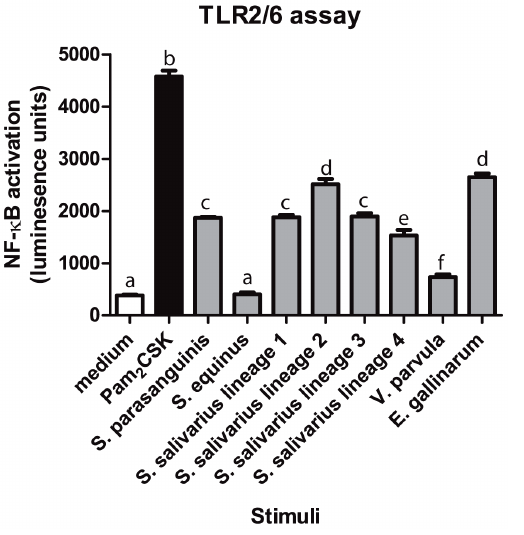
Figure 4. TLR2/6 signalling capacities of bacterial strains. HEK293 cells were incubated with the small- intestinal strains at a cell to bacteria ratio of 1:10, PAM 2 CSK as a positive control and medium as a negative control (n 5 3). This figure is representative out of two hTLR2/6